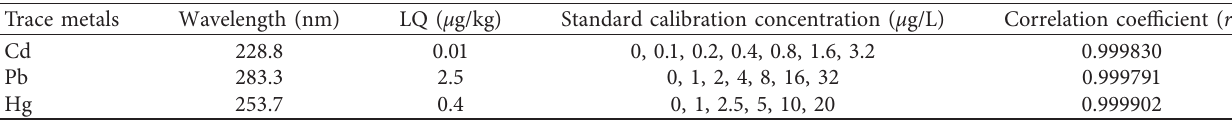
Table 1: The wavelength, limit of quantification (LQ), standard calibration concentration, and correlation coefficient ( r ) for trace metals determination.